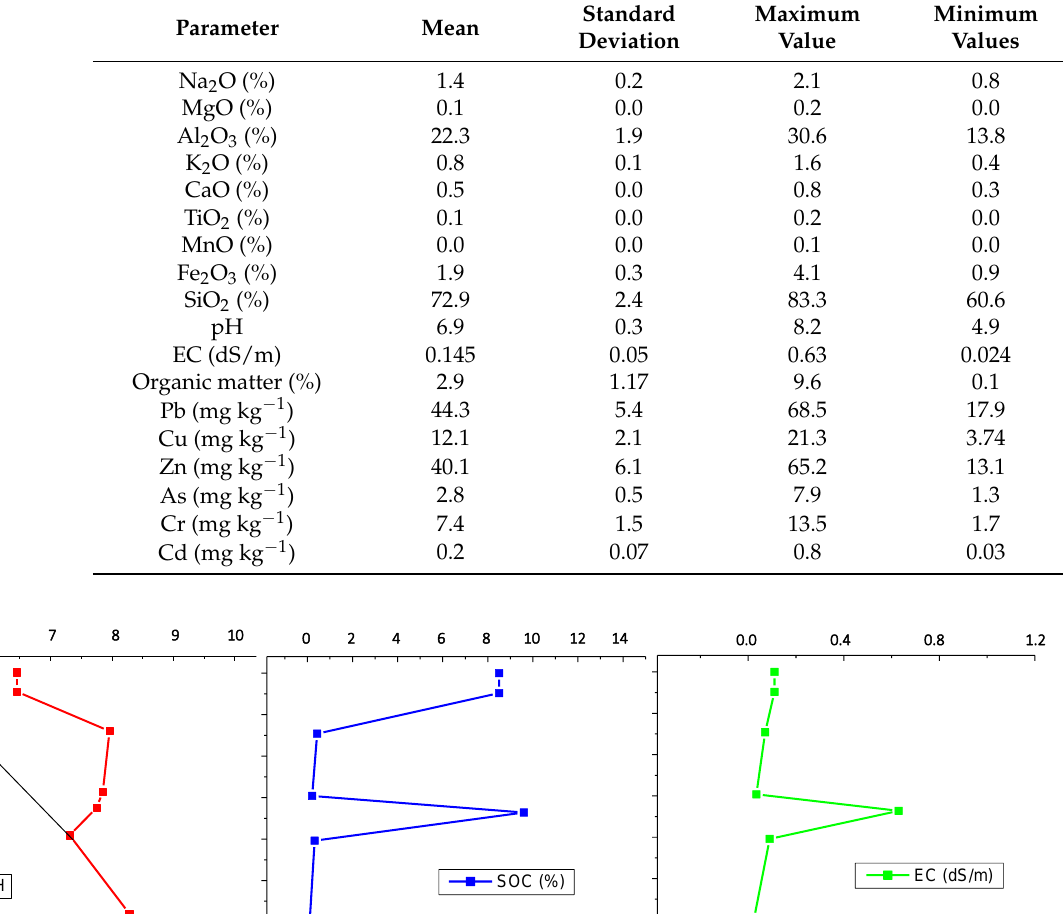
Table 2. Summary statistics of the analytical results.